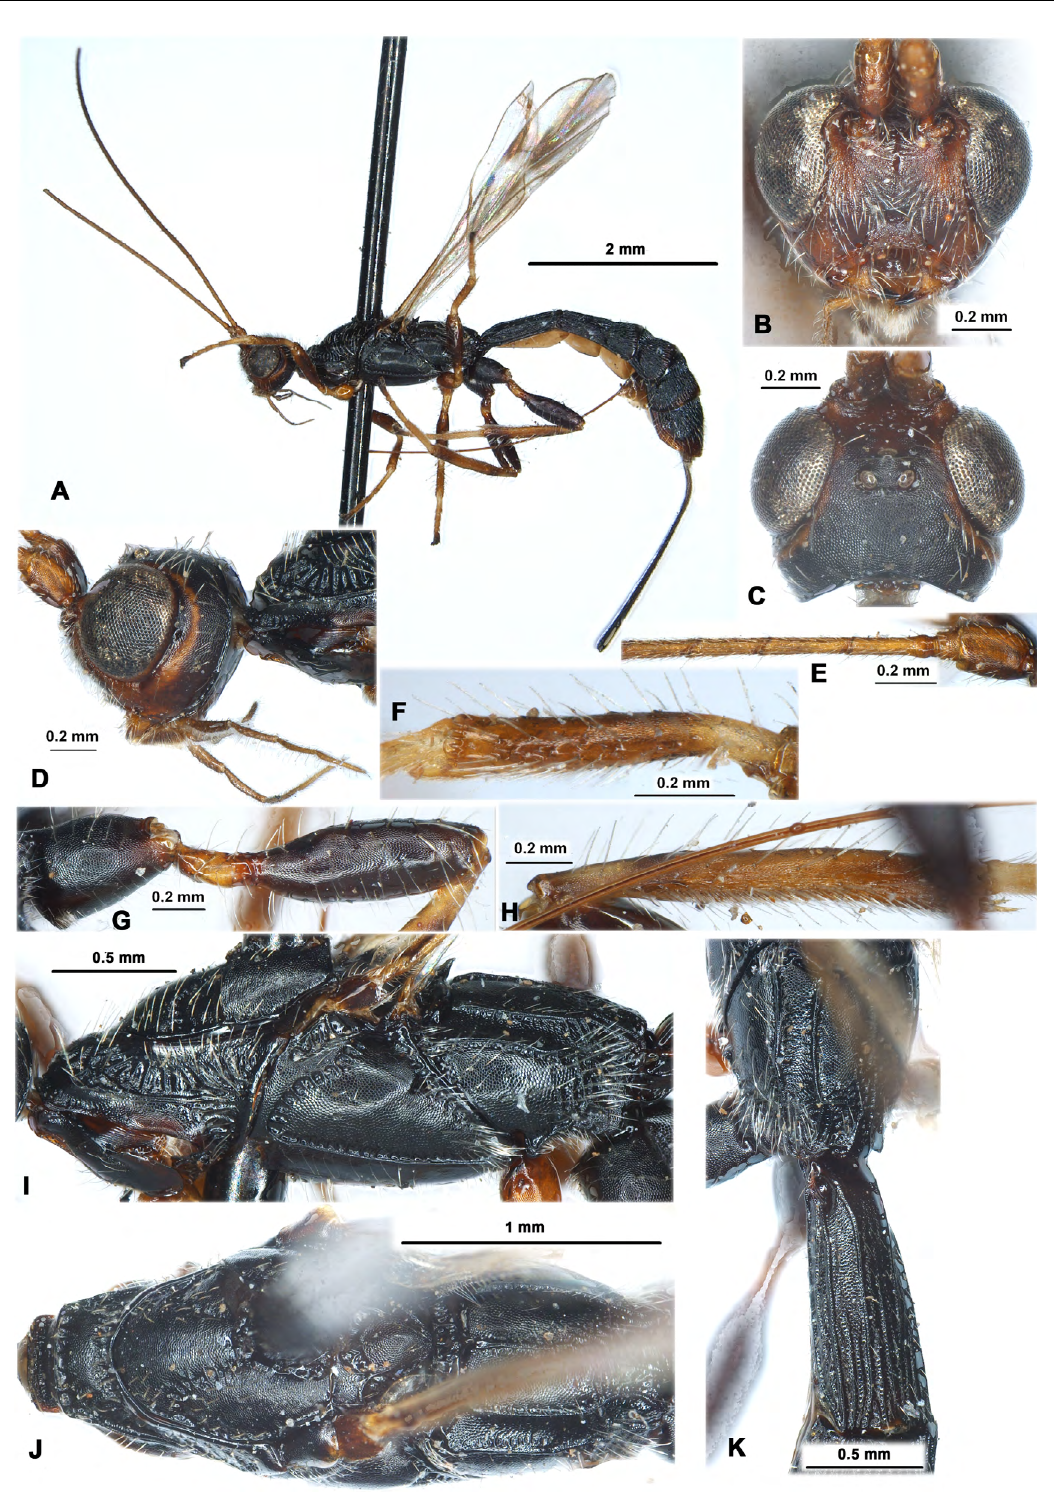
Fig. 58. Troporhaconotus jacobsoni (Szépligeti, 1908) gen. et comb. nov., ♀, holotype, HNHM. A . Habitus, lateral view. B . Head, front view. C . Head, dorsal view. D . Head, lateral view. E . Basal segments of antenna. F . Fore tibia. G . Hind coxa and femur, lateral view. H . Hind tibia, lateral view. I . Mesosoma, lateral view. J . Mesosoma, dorsal view. K . Propodeum and first metasomal tergite, dorsal